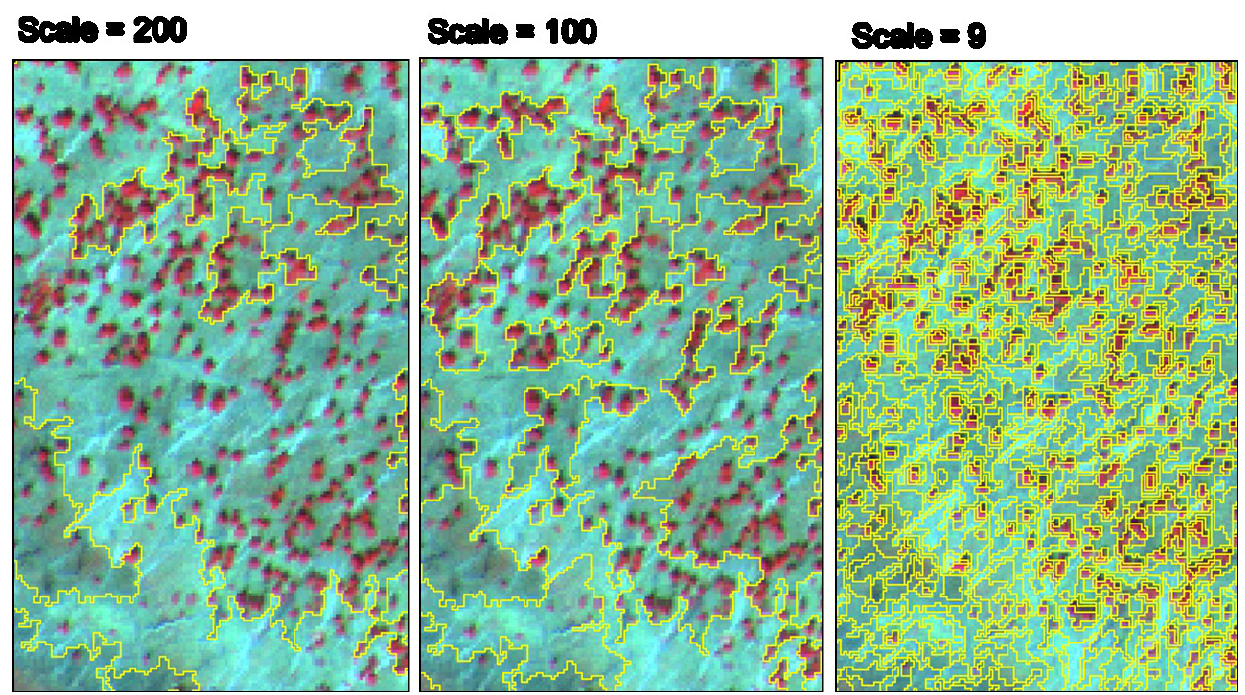
Figure 4. Examples of different scale parameters and impacts on the